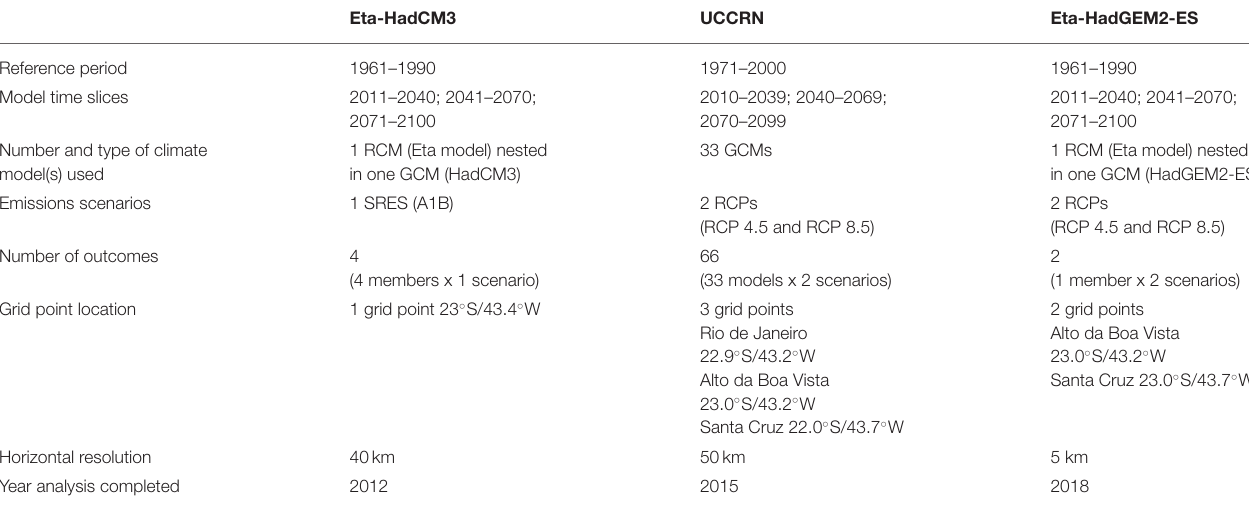
TABLE 2 | Comparison of three downscaling methods: Eta-HadCM3, UCCRN, and